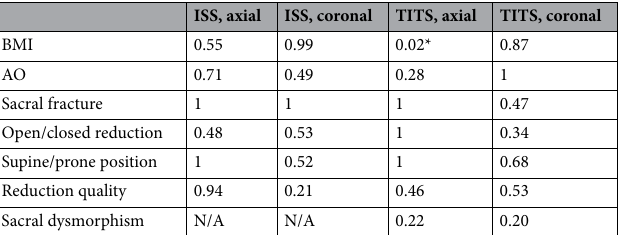
Table 5. Univariate analysis of risk factors for mal-angulation of the ISS and TITS. ISS iliosacral screw, TITS trans-iliac trans-sacral screw, BMI body mass index, AO Arbeitsgemeinschaft für Osteosynthesefragen, N/A not available. * p <